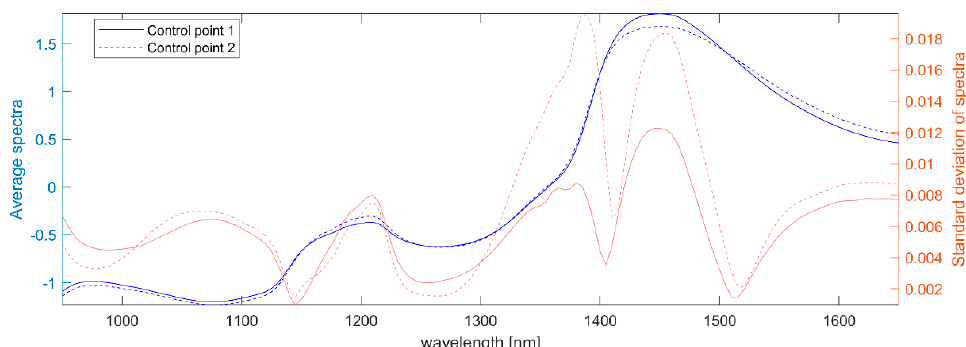
Figure 2. Standard normal variate (SNV) pre-processed calibration spectra, 1/log(X) transformed for absorbance, from the in-line NIRS instrument: mean (left axis, blue) for each of the control points (drawn with different line styles) along with standard deviations (right axis , orange).